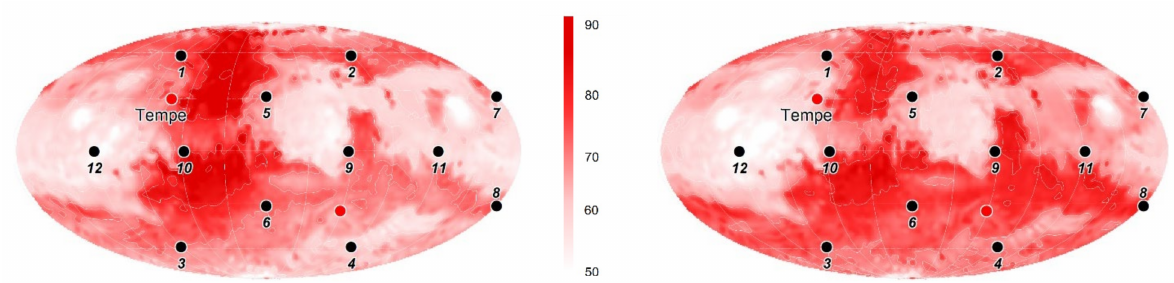
Figure 20. Temperature increase after 100 Martian years: “factory” alternative ( left ), “asteroid” alternative ( right